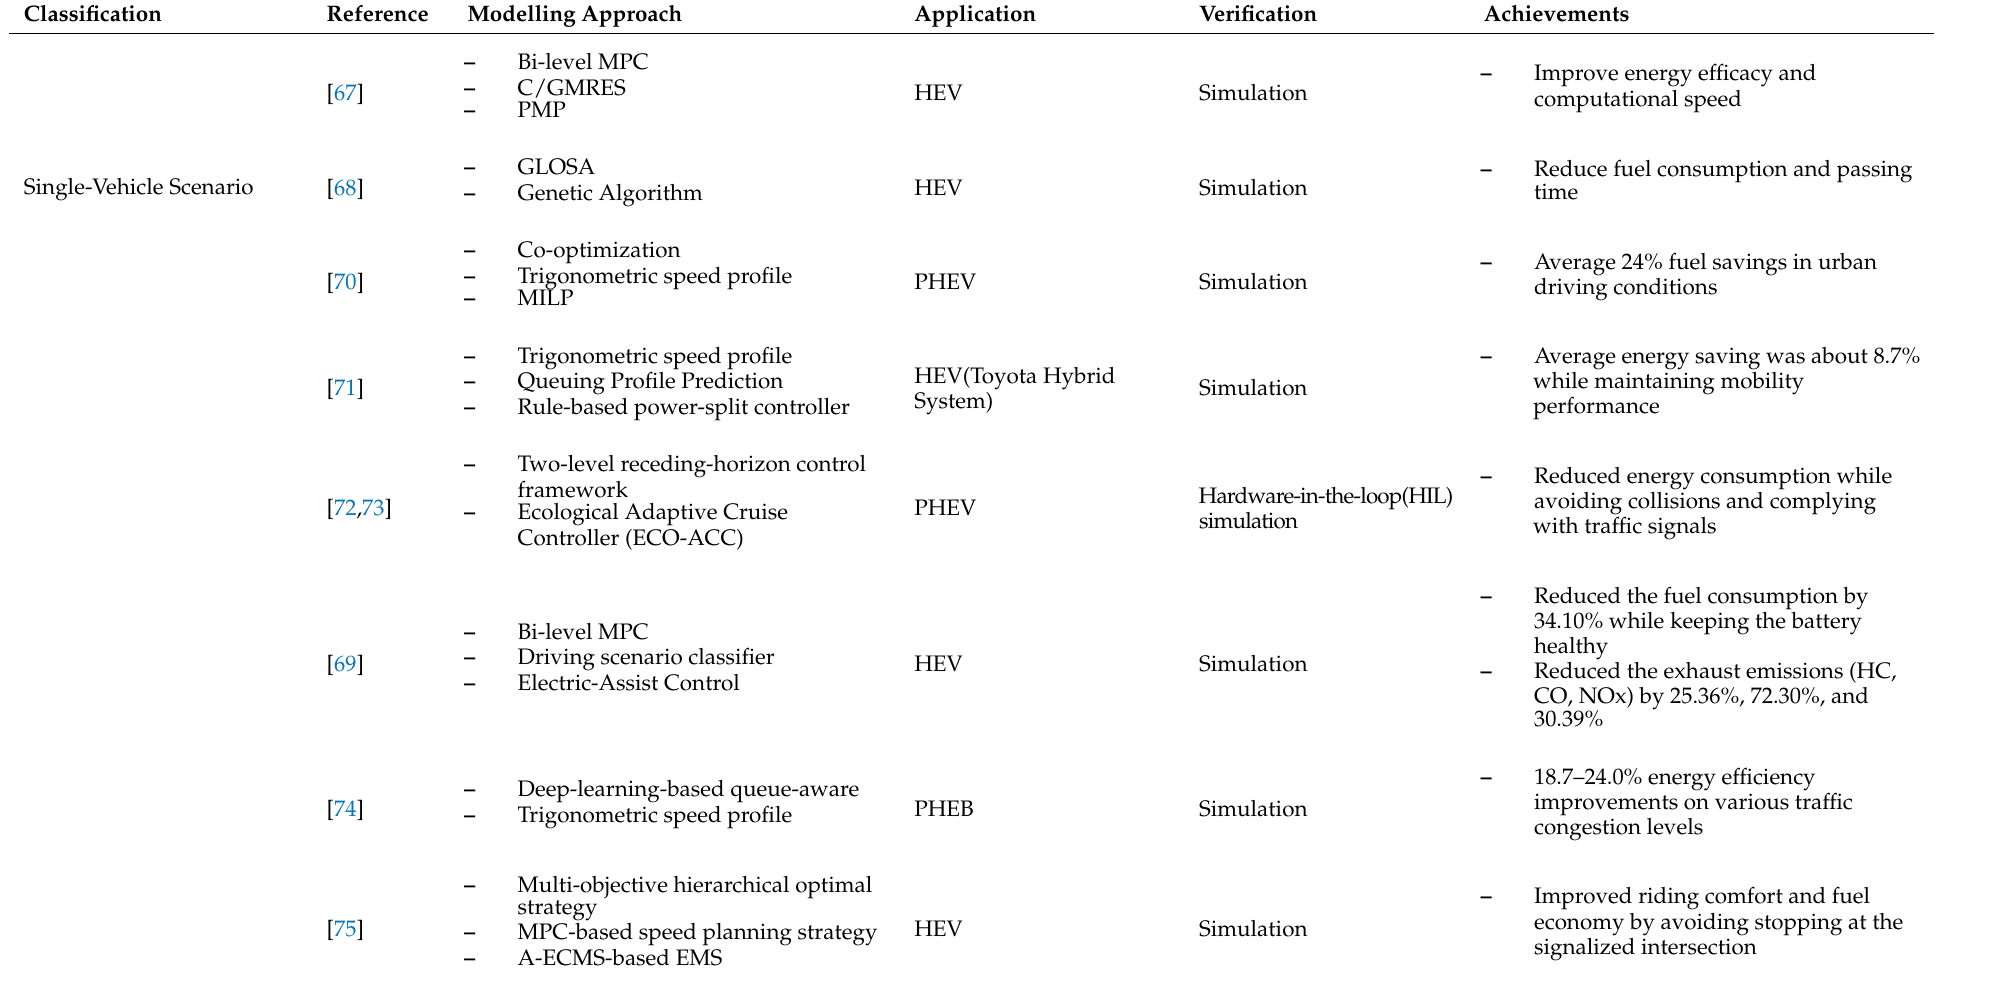
Table 1. Summary of exemplary works on co-optimization of eco-driving and energy management for HEV/PHEVs near signalized